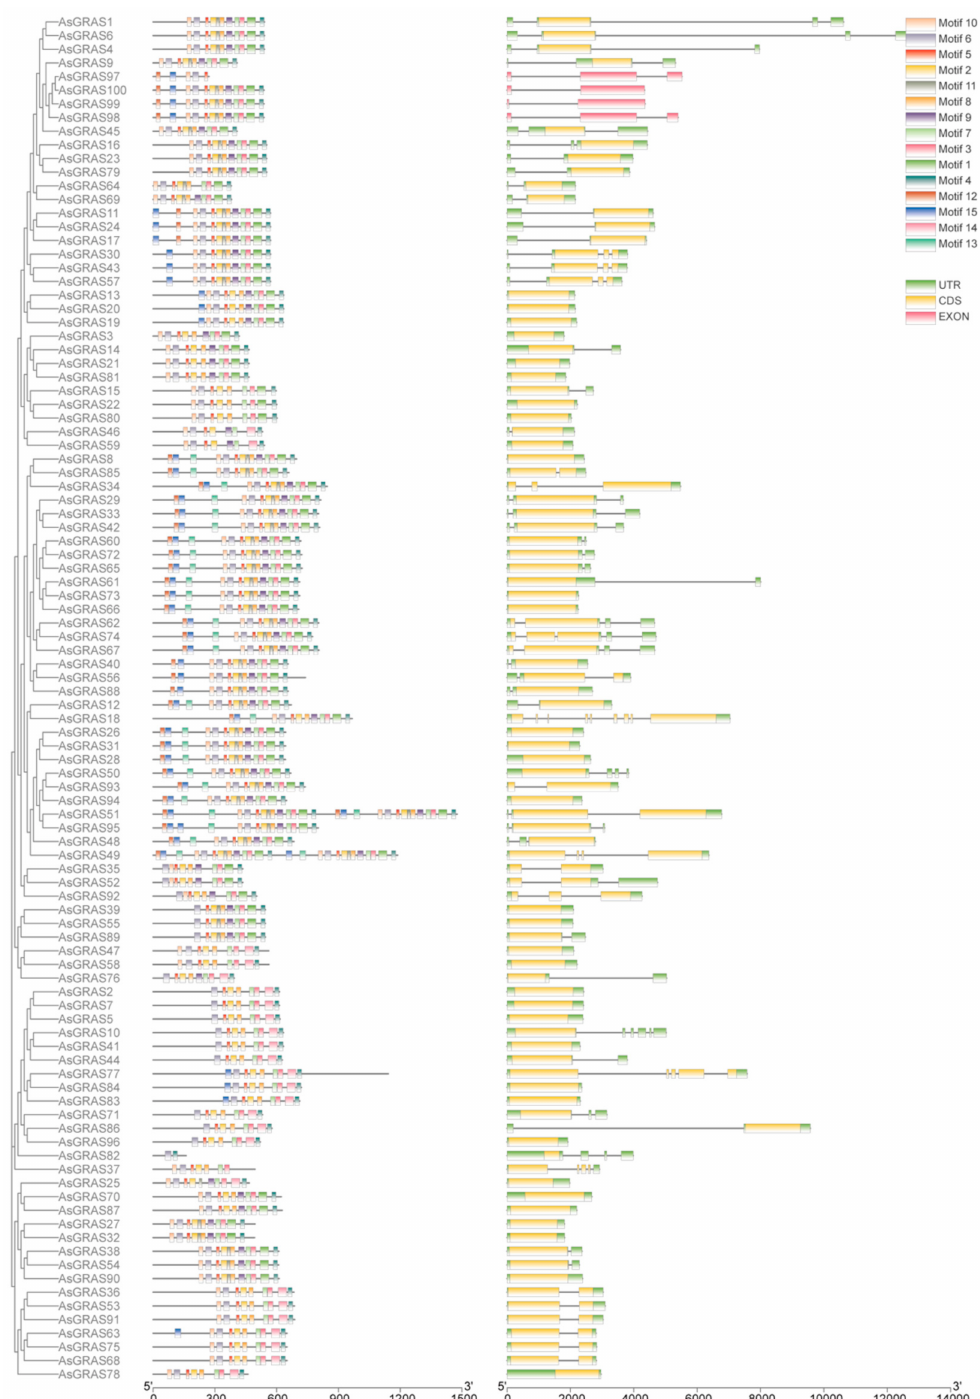
Figure 2. Gene structure analysis of the Avena sativa GRAS gene